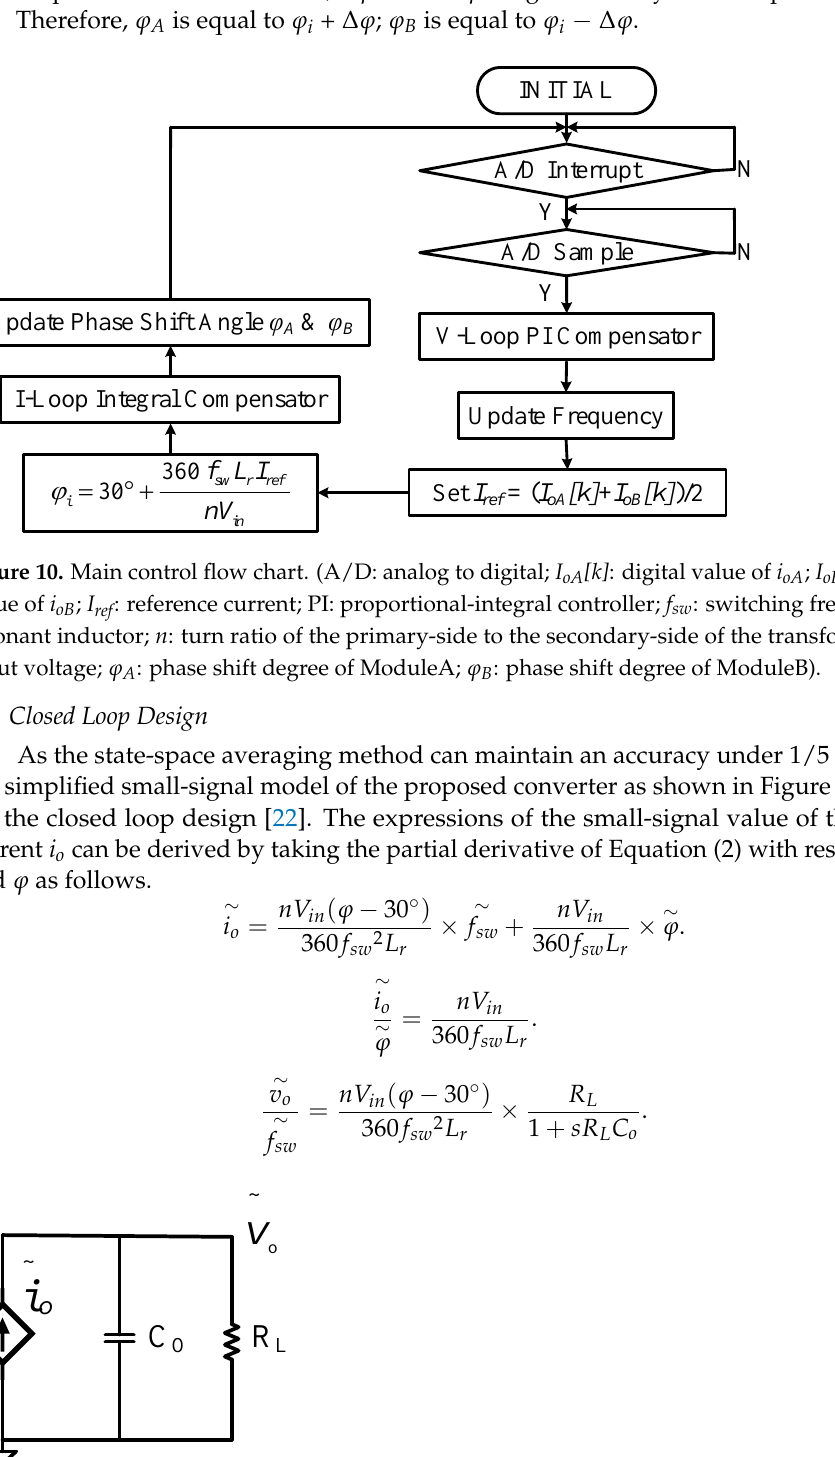
Figure 9. Digital control block diagram. ( i oA : output current of ModuleA; i oB : output current of ModuleB; H v (s) ; H i (s) ; ADC: analog to digital converter; k : sampled digital control cycle; V o [k] : digi- tal value of V o ; I oA [k] : digital value of i oA ; I oB [k] : digital value of i oB ; I ref : reference current; PI: propor-